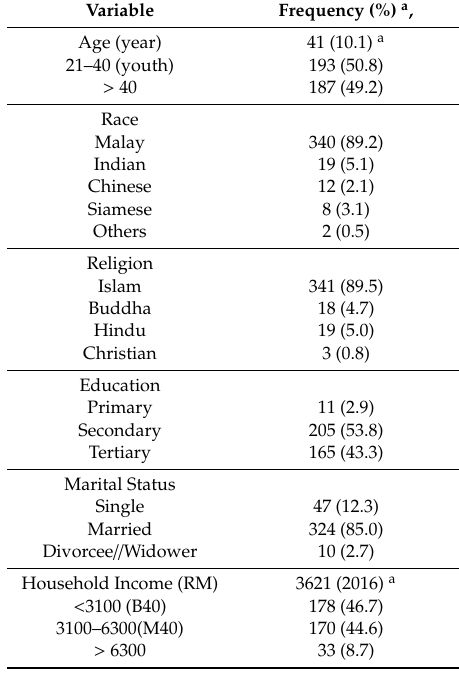
Table 1. Sociodemographic characteristics of participants ( n =